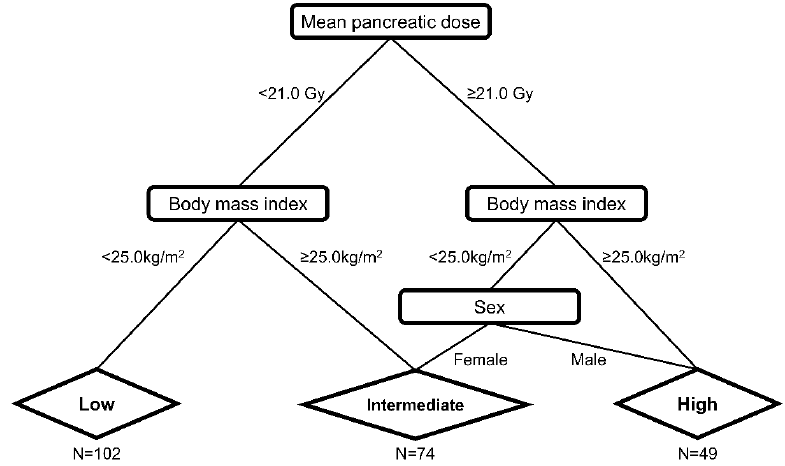
Figure 2. Diabetes mellitus risk prediction groups defined by recursive partitioning analysis in pa- tients with gastric mucosa-associated lymphoid tissue lymphoma. The patients with D mean < 21.0 Gy and BMI < 25.0 kg/m 2 were defined as the low-risk group (n = 102). Among the patients with D mean ≥ 21.0 Gy, those with BMI ≥ 25.0 kg/m 2 or male patients with BMI < 25.0 kg/m 2 were defined as having high risk (n = 49). The remaining patients not included in either the low- or high-risk groups were defined as being in the intermediate-risk group (n = 74). D mean , mean dose in gray irradiated to the whole pancreas; BMI, body mass index.